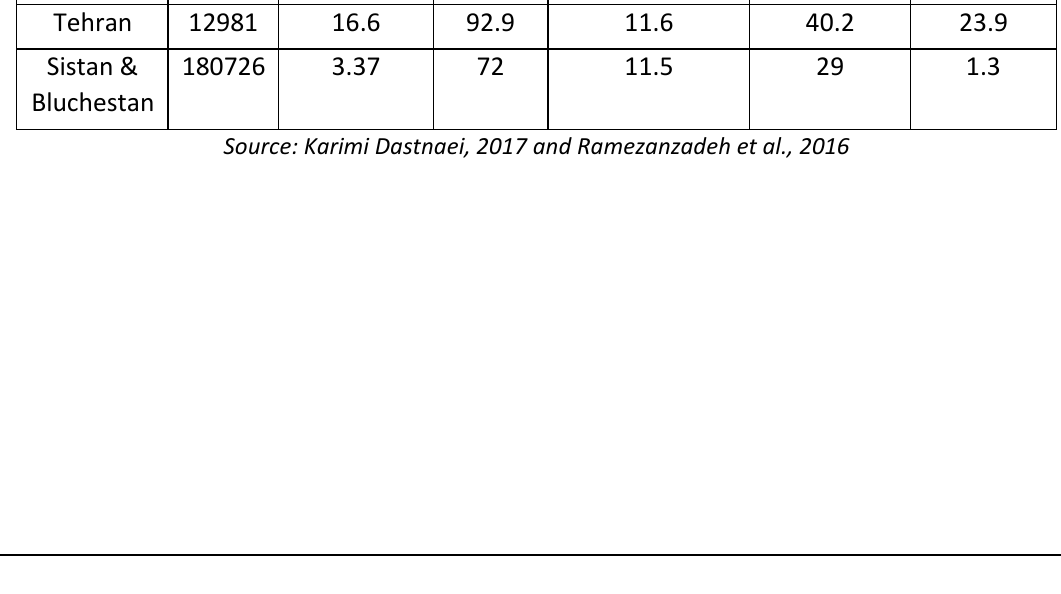
Percent of GDP (to the